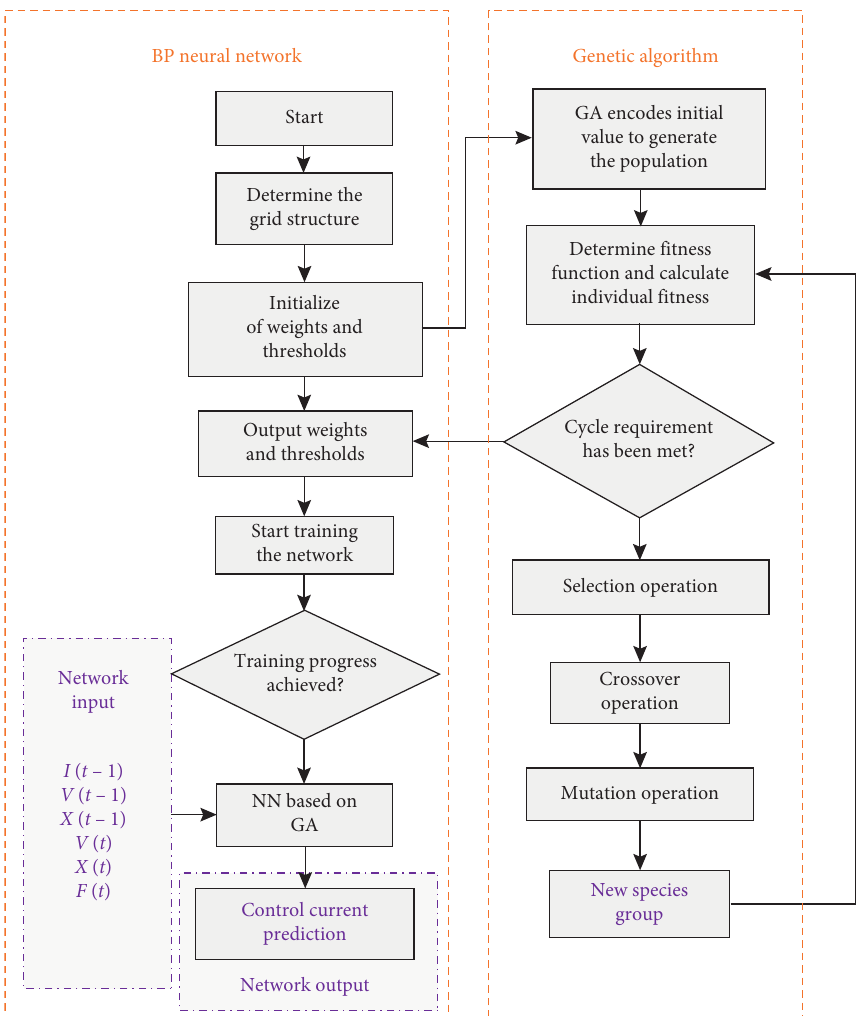
Figure 5: Schematic diagram of the GA-BP inverse dynamic model of the MR damper.